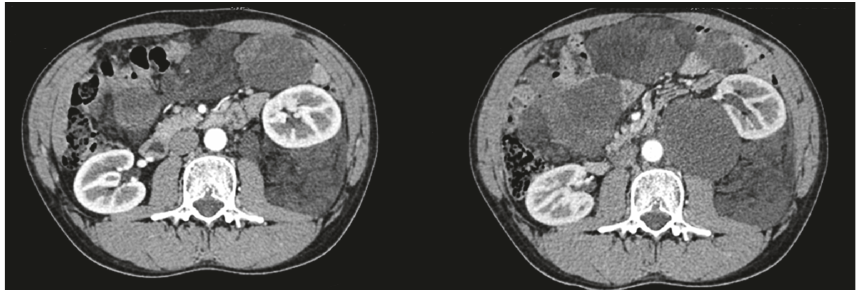
Figure 1: Multidetector computed tomography (MDCT) scan after contrast medium (arterial phase). Progression of abdominal metastasis from a myxoid liposarcoma after two cycles of high-dose prolonged-infusion ifosfamide.